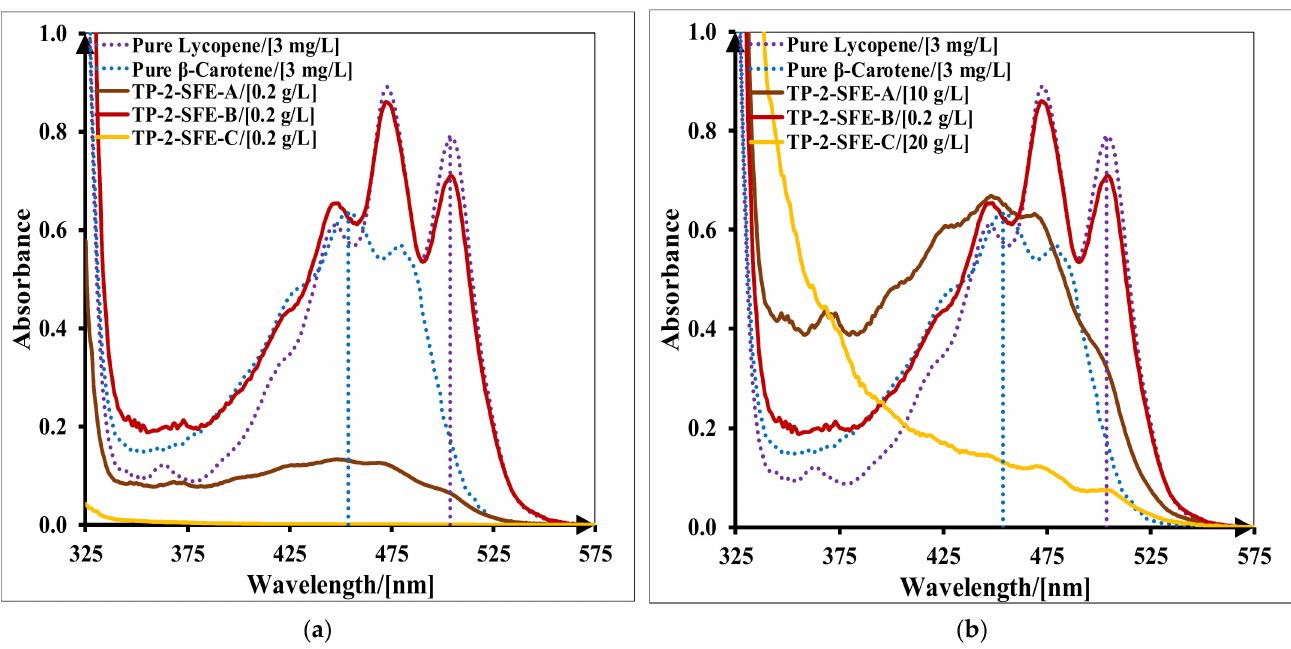
Figure 6. UV–VIS spectra of SFE fractions (SFE-A, SFE-B, SFE-C) obtained from tomato pomace (TP) with operating parameter set (2) at 450 bar, 70 ◦ C and 11 kg/h (TP-2-SFE): ( a ) fraction concentrations (SFE-A—0.2 g/L, SFE-B—0.2 g/L, SFE-C—0.2 g/L); ( b ) fraction concentrations (SFE-A—10 g/L, SFE-B—0.2 g/L, SFE-C—20